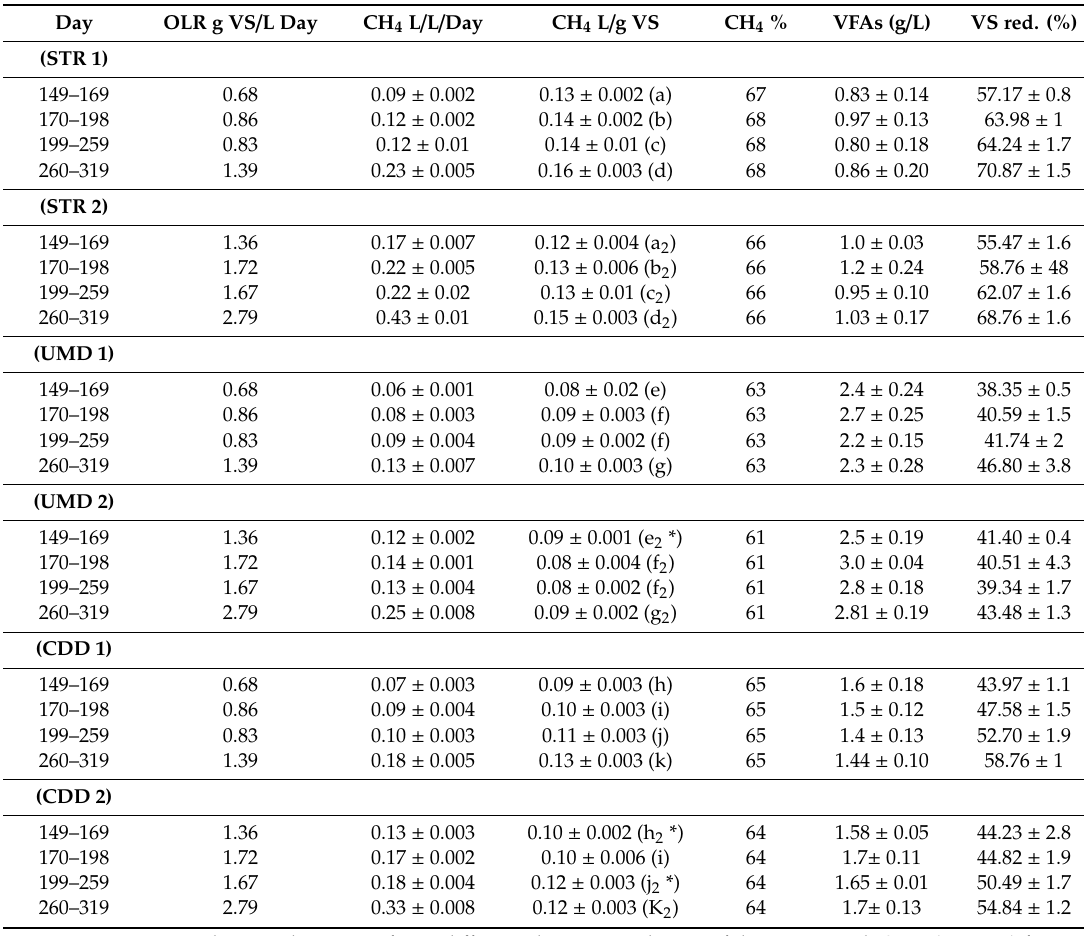
* Letters in parentheses indicate significant di ff erence between each type of digester at each OLR, ( p < 0.05) for specific methane production a to k; a 2 to k 2 . Values with the same alphabet means no significant di ff erence. Alphabets with (*) mean value is higher and not